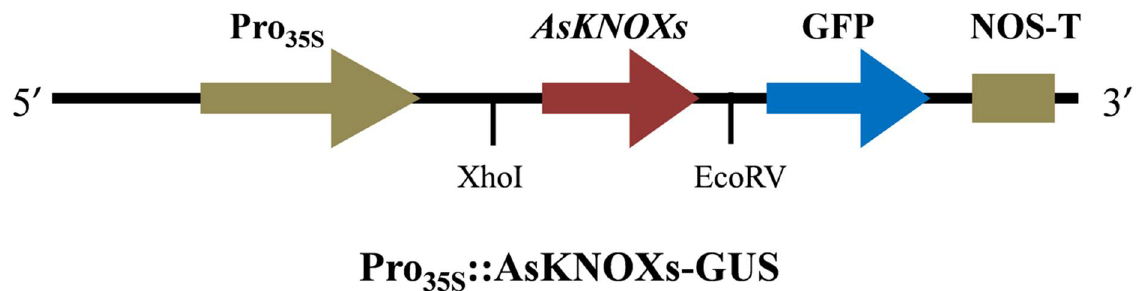
Figure 9. The connection mode of AsKNOX genes and vector.